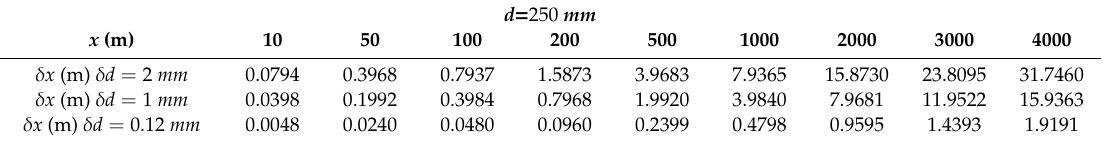
Table 3. Horizontal positioning error of USBL caused by the spacing error of the array elements. ( d = 250 mm , x-axis direction).